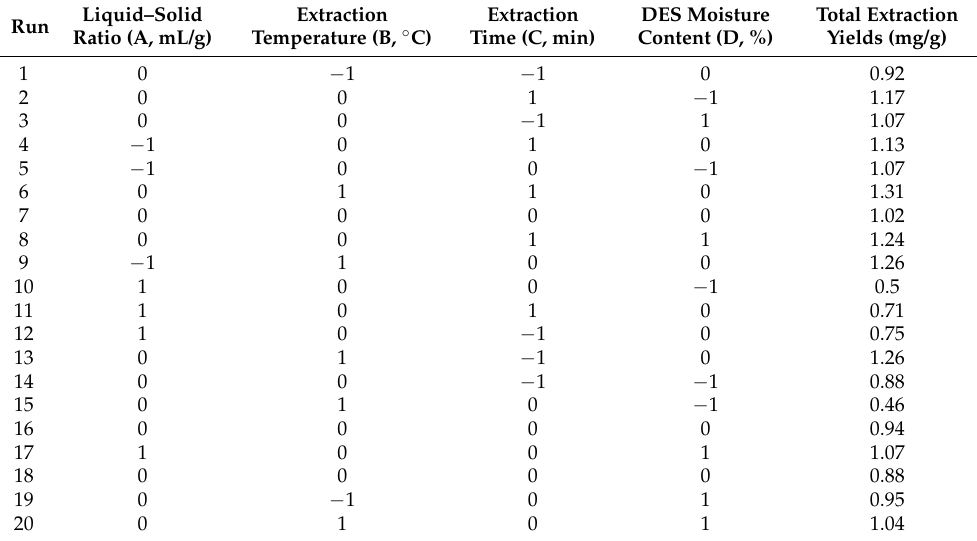
Table 4. Experimental order, variable levels, and response values in Box–Behnken designs.